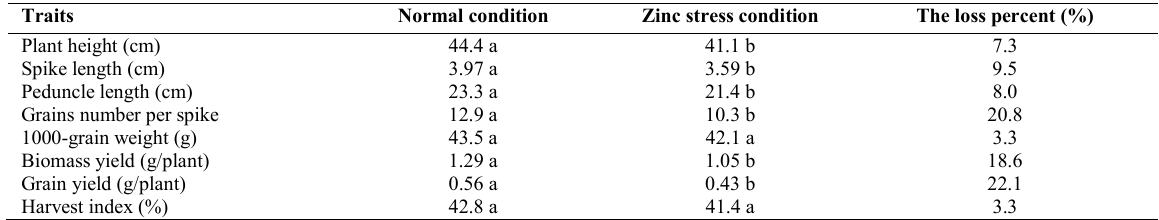
Table 4. The average values of the studies traits under normal and zinc stress conditions, and the loss percent of each traits after the stress treatment in durum wheat ( Triticum durum